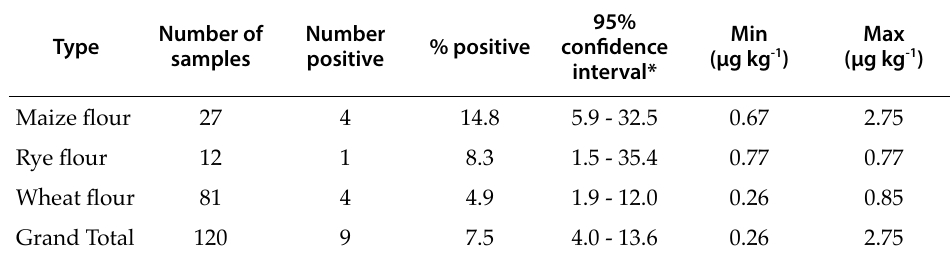
Table 4. The amounts of ochratoxin A in the different flour sample.